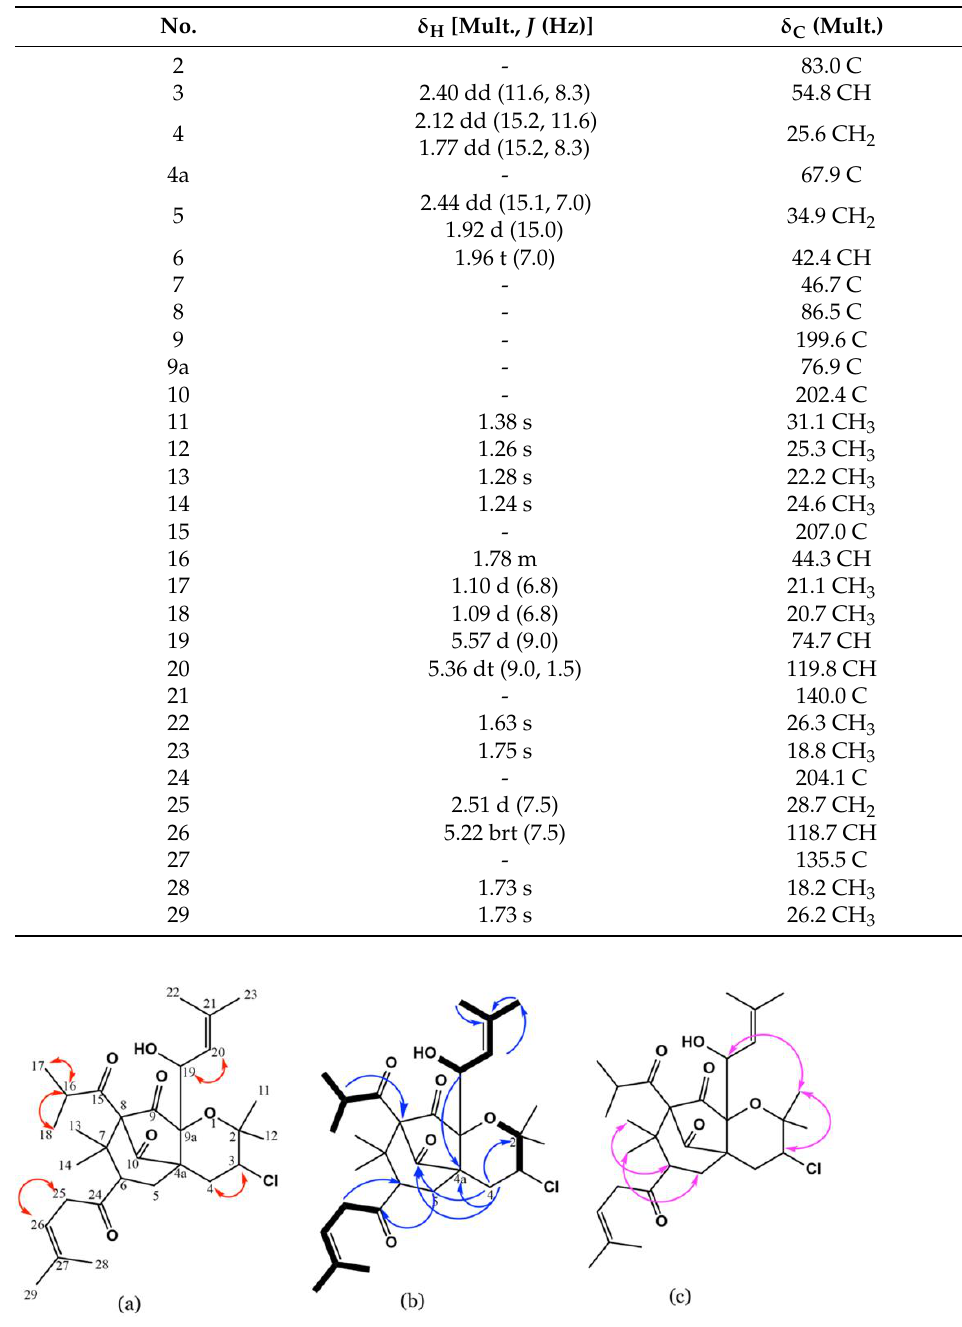
Figure 4. Effect of the H. revolutum chloroform fraction on PE-precontracted separated intact or de- nuded aorta or aorta preincubated with a nitric oxide synthase inhibitor (L-NAME) compared with time control. Results are introduced as the mean ± standard error of the mean (SEM) ( n = 8). * Significantly varies from the corresponding time control values ( p < 0.05); # Significantly varies